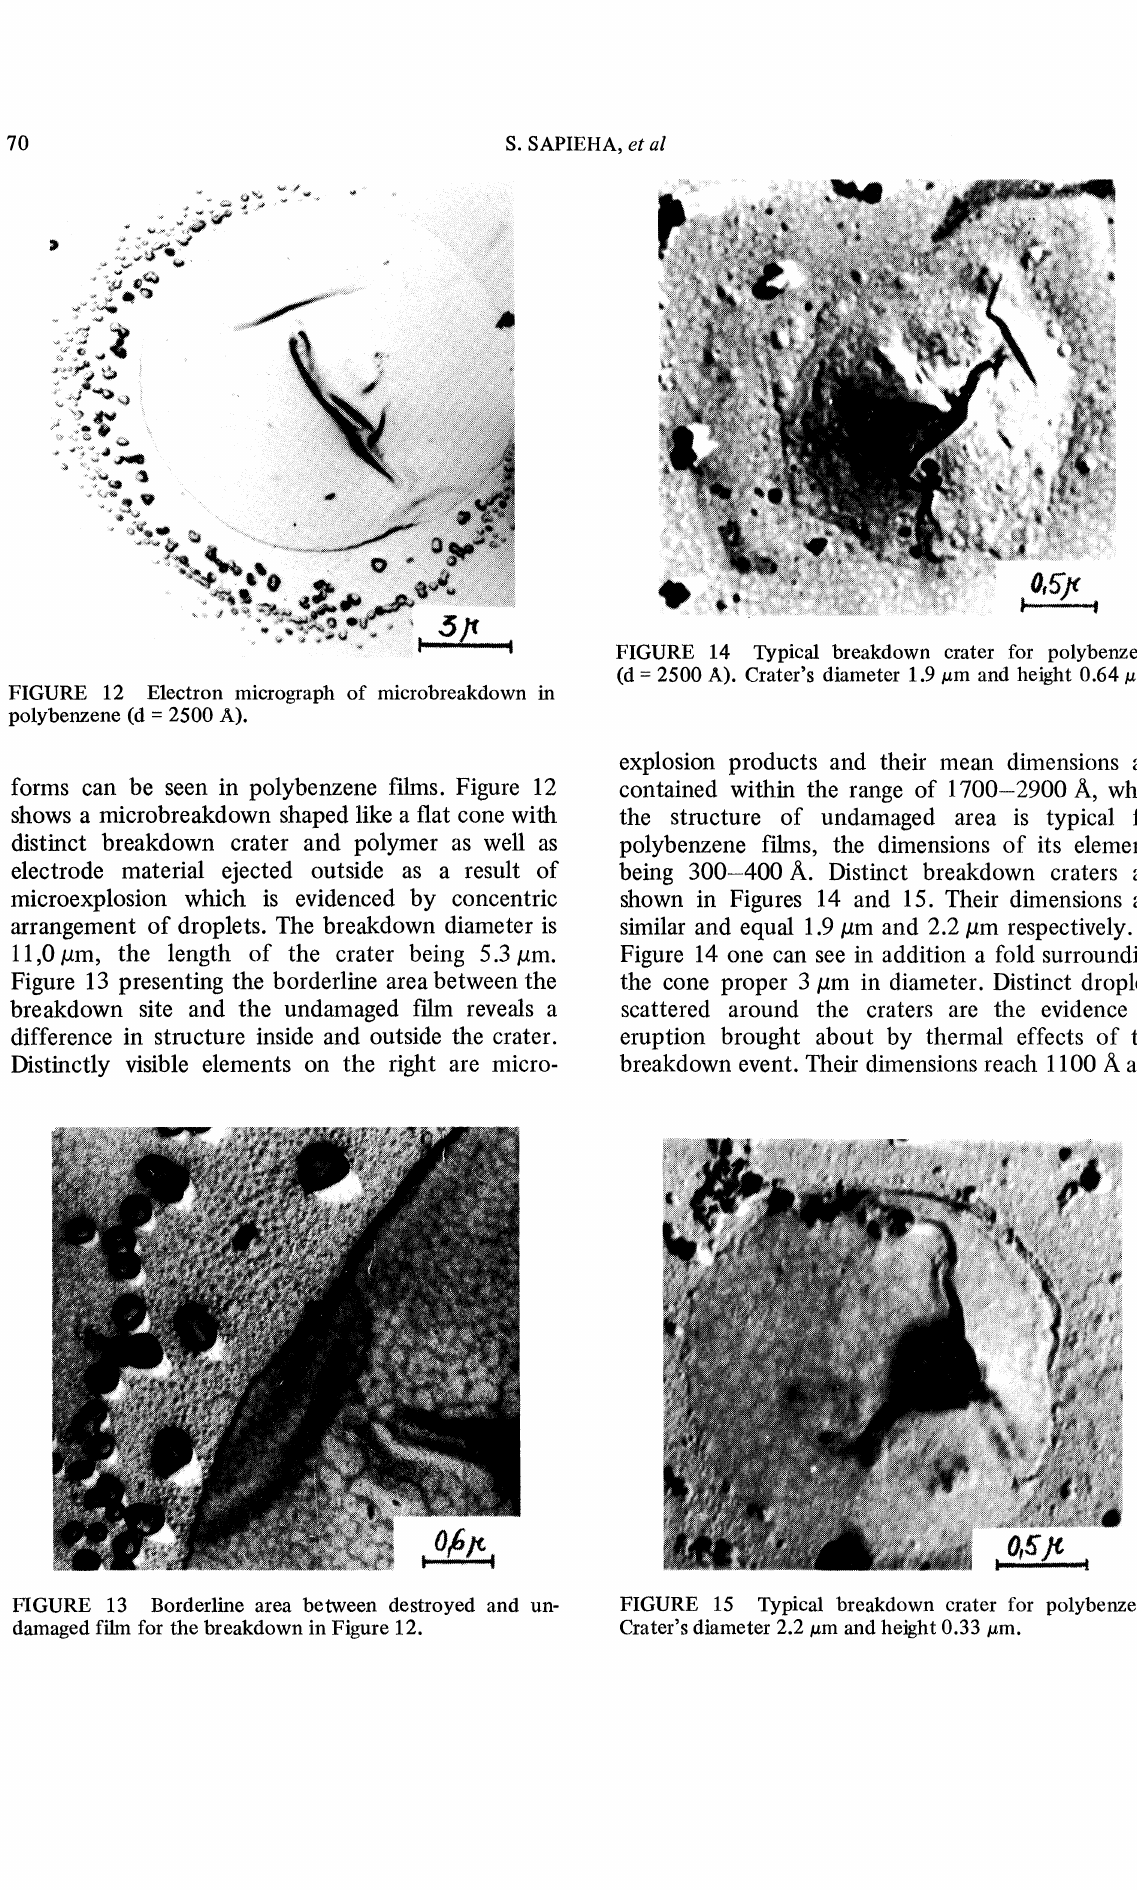
FIGURE 15 Typical breakdown crater for polybenzene. Crater’s diameter 2.2 m and height 0.33